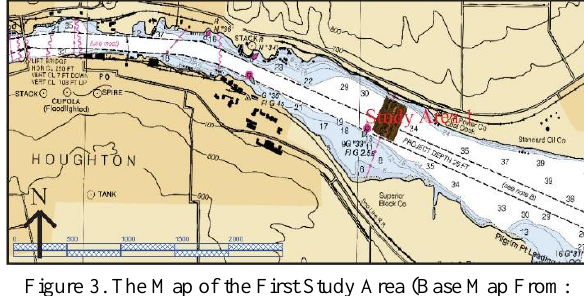
Figure 3. The Map of the First Study Area (Base Map From: